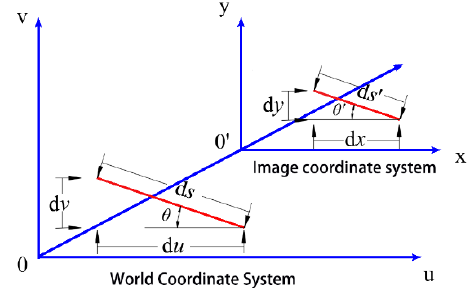
Figure 2. Coordinate system mapping.